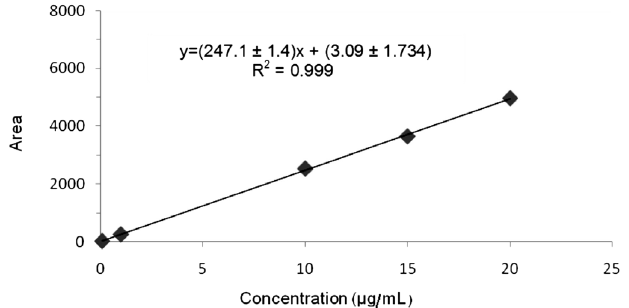
FIGURE 5 - Linear range of HPLC-UV method for LSD determination, demonstrating curve equation and determination coefficient.